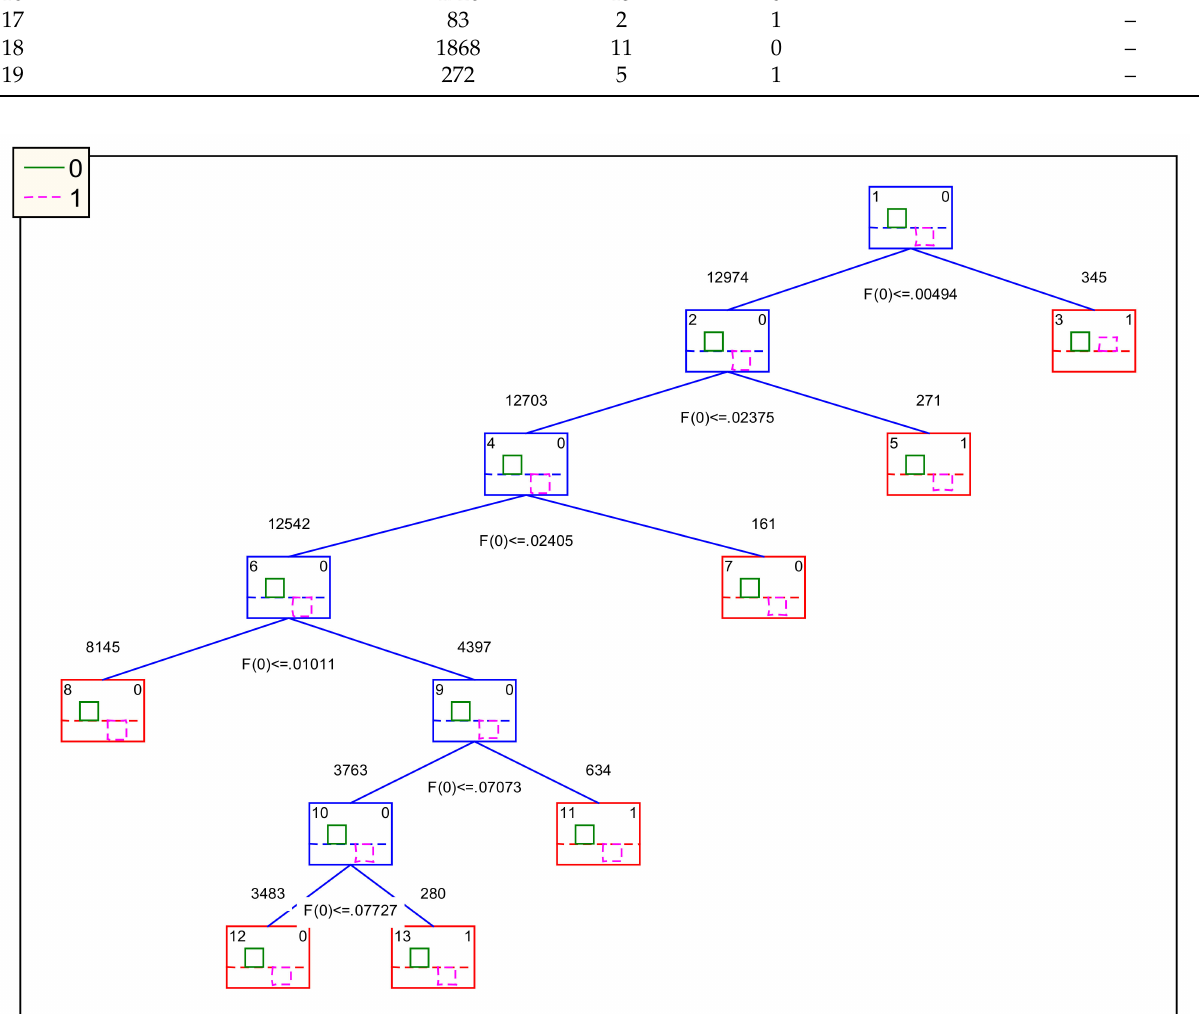
Figure 4. IFPTML-CTLC model decision